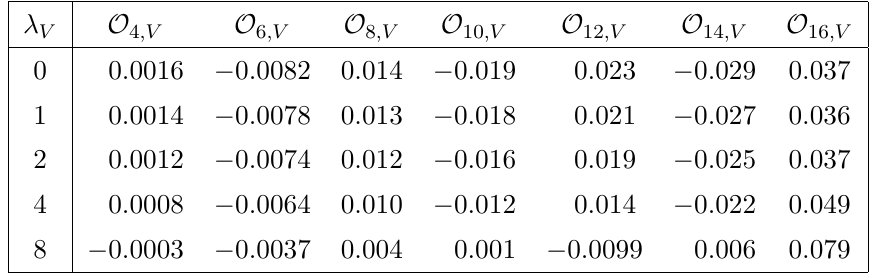
Table 15 . Fitted values of the OPE condensates in GeV units, with FOPT and ˆ s 0 = 1 . 55 GeV 2 , for different values of the power λ V